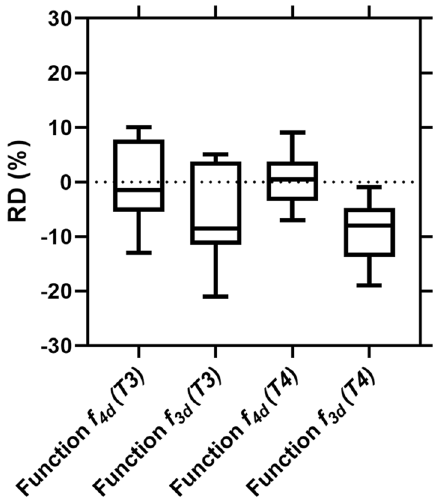
Fig. 3 RDs of TIAs obtained from the function f 4 d and f 3 d for STP dosimetry at T 3 and T4. TIAs from all-time-point fittings calculated using function f 4 d were used as the reference